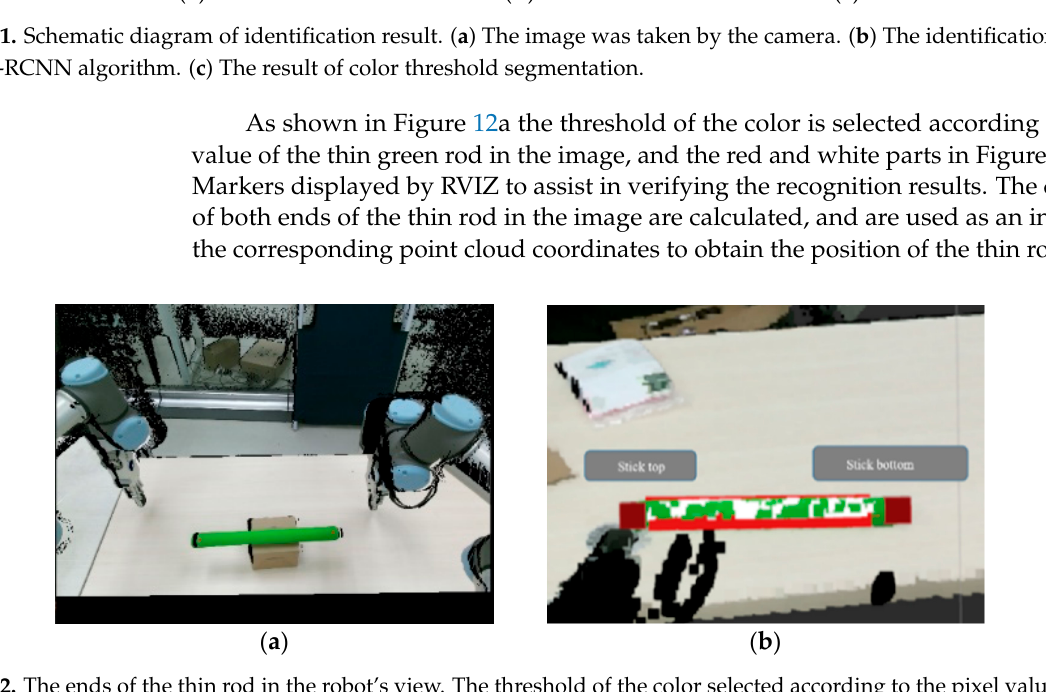
( c ) Figure 13. ( a – c ) The process of physical robot completes the grasping task.